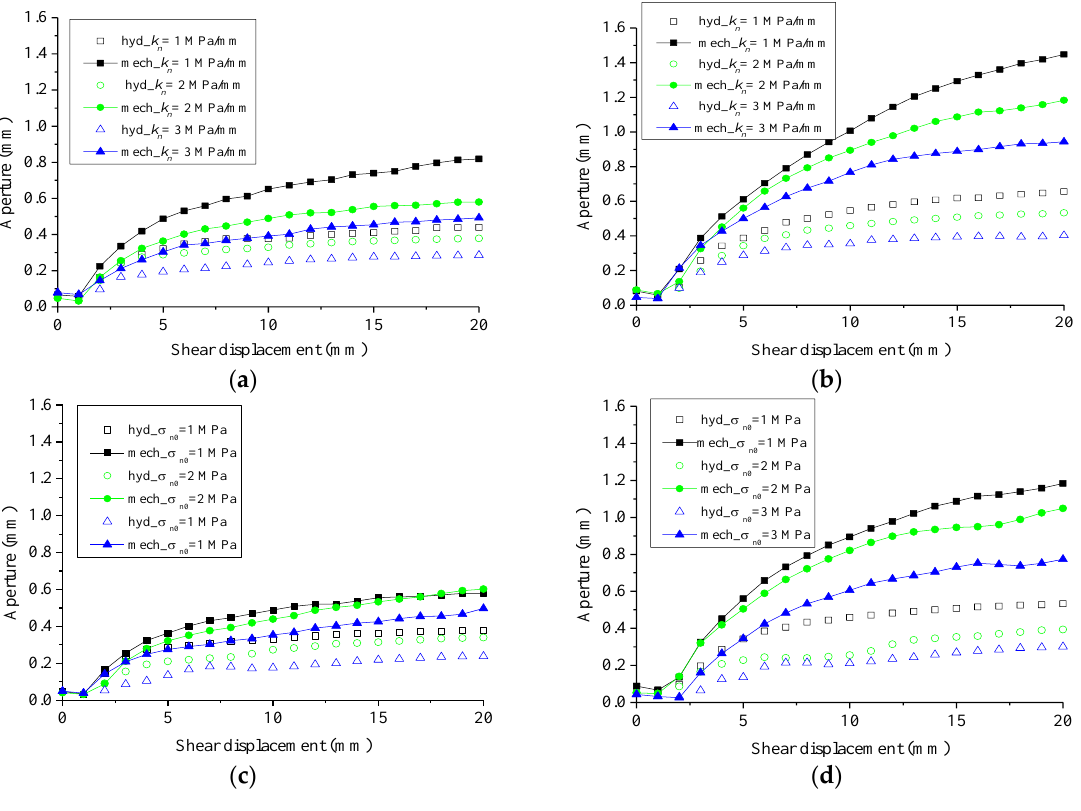
Figure 5. Evolution of the hydraulic and the mechanical apertures of the replicas G1 and G3, during shearing, under different boundary conditions. ( a ) Replica G1 with different normal stiffness, under an initial normal stress of 1 MPa. ( b ) Replica G3 with different normal stiffness, under an initial normal stress of 1 MPa. ( c ) Replica G1 with different initial normal stresses, under a constant normal stiffness of 2 MPa/mm. ( d ) Replica G3 with different initial normal stresses, under a constant normal stiffness of 2